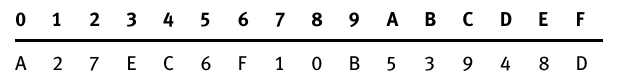
Figure 1: General scheme of the LBC - 3